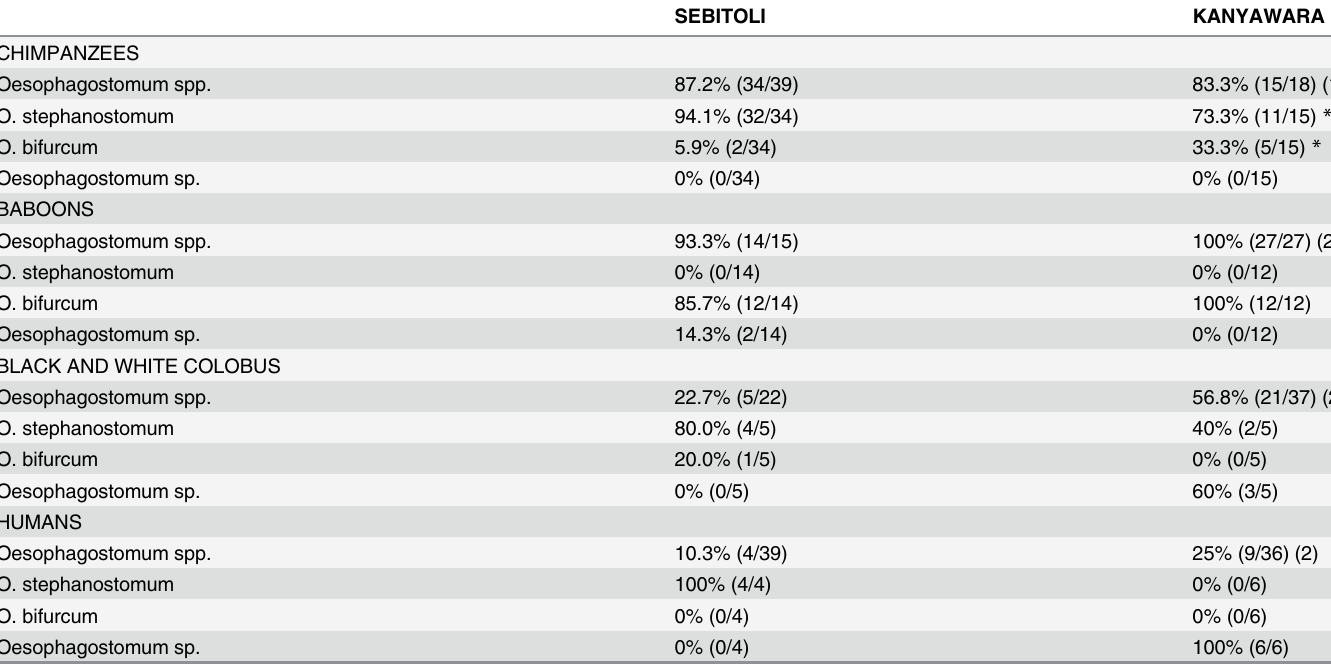
Table 3. Prevalence in Oesophagostomum species and subspecies at Sebitoli and Kanyawara as determined by PCR. (1) [17]; (2) [18].